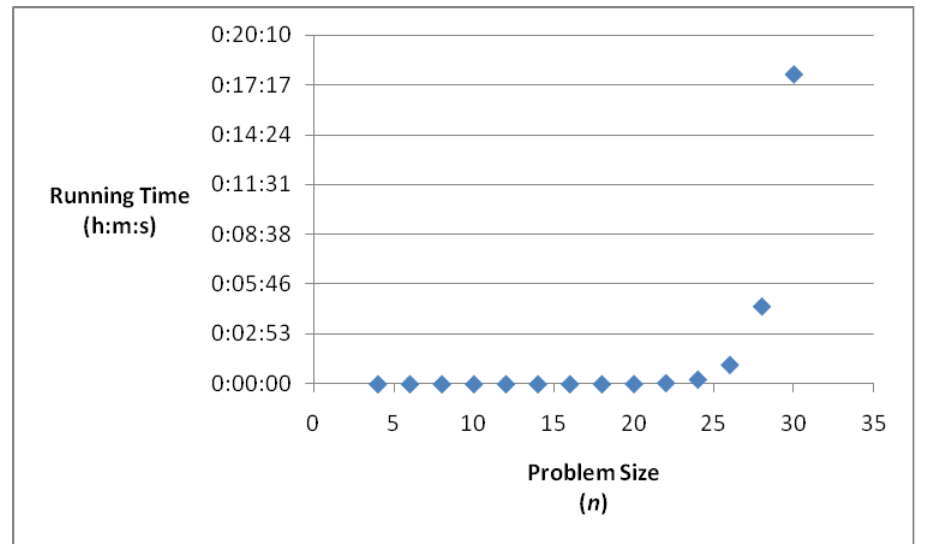
Figure 2. Running Time of Permute + vs. Problem